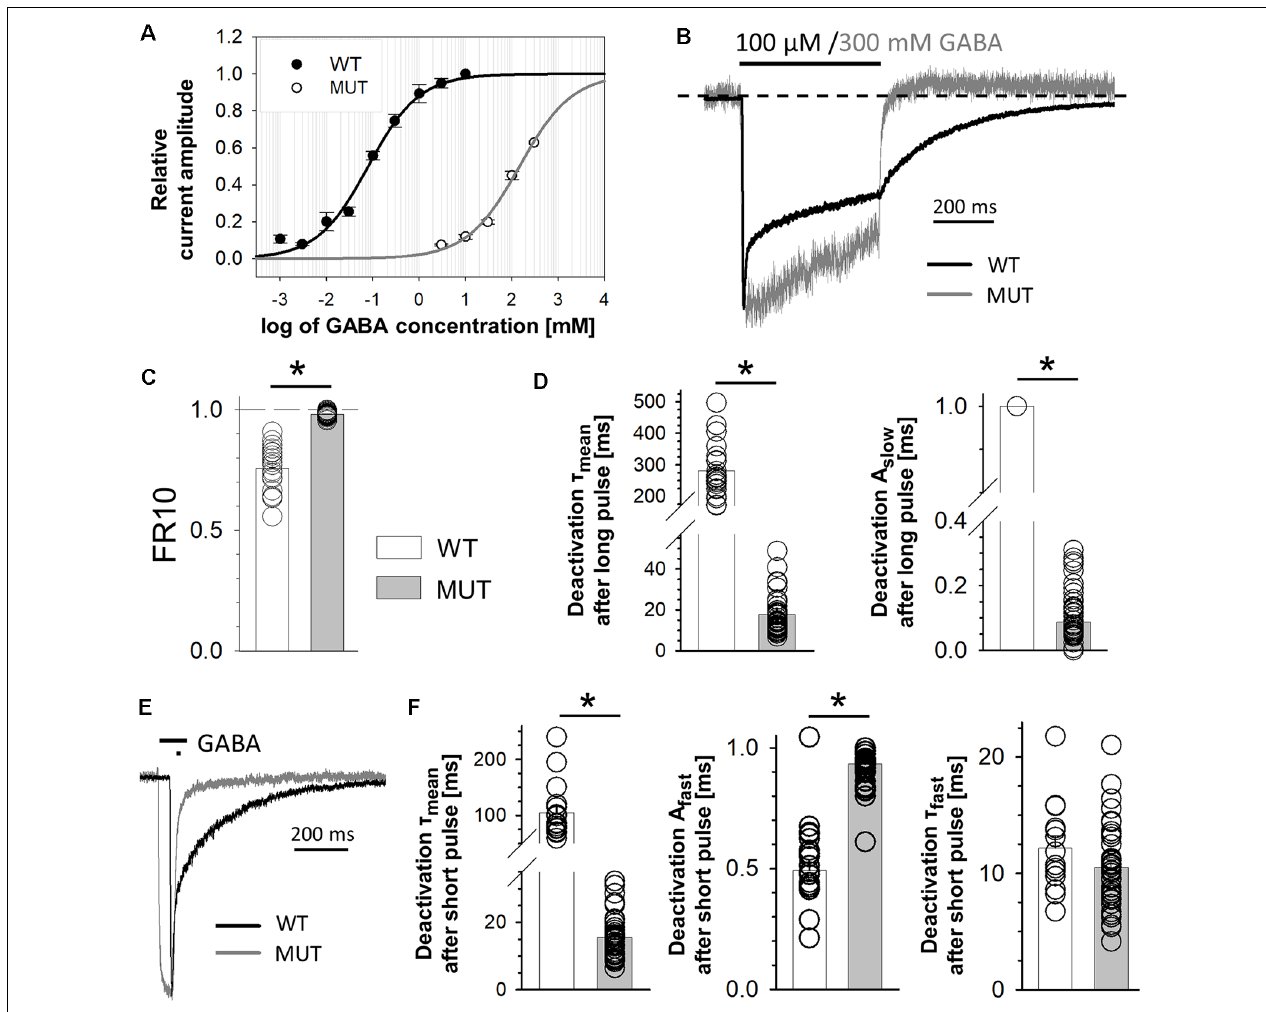
FIGURE 1 | The impact of β 2 E155C mutation on GABA-evoked macroscopic currents. (A) GABA dose–response relationships with fitted Hill’s curves for α 1 β 2 γ 2 [wild type (WT), EC 50 : 79.2 µ M, n H : 0.79] and α 1 β 2 E155C γ 2 [mutated GABA A receptors (GABA A Rs; MUT), EC 50 : 146 mM, n H : 0.76] GABA A Rs. Note that this mutation strongly right shifted the dose–response dependence. (B–D) The impact of mutation on the kinetics of macroscopic currents evoked by a prolonged (500 ms) application of GABA. (B) Typical traces of normalized current responses mediated by WT (black) and MUT (gray) receptors to pulses of 100 µ M and 300 mM GABA, respectively. Baseline level is marked with a dashed line to make a spontaneous activity-related current overshoot (after agonist removal, see Jatczak- ´ Sliwa et al., 2018) clearly visible. Note a strong effect of mutation on macroscopic desensitization. (C) Statistics for the fraction of current remaining after 10 ms from the peak. Note that mutation abolishes the fast component of macroscopic desensitization. (D) Statistics of deactivation kinetics after long (500 ms) GABA application—mean time constant ( τ mean , left) and percentage of the slow component (A slow , right). (E,F) The impact of mutation on deactivation kinetics after short (few ms) GABA application. (E) Typical traces of macroscopic currents elicited by short pulses of GABA mediated by WT (black) and MUT (gray) receptors. (F) Statistics of deactivation kinetics after short pulses of GABA—mean time constant ( τ mean , left), percentage of the fast component (A fast , middle) and its time constant ( τ fast , right). Note that mutation accelerates deactivation kinetics after long pulse mainly by decreasing the percentage of slow deactivation phase while in the case of deactivation after short agonist application also by decreasing the time constant of the fast component. Asterisks indicate statistically significant